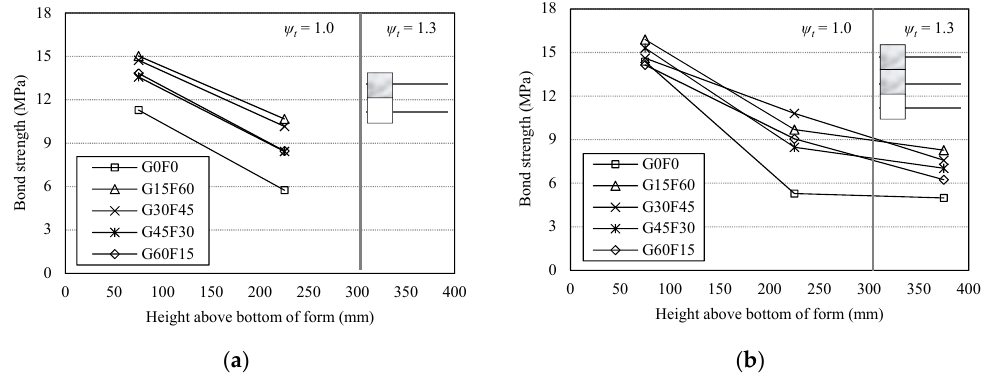
Figure 9. Comparison of bond strength levels in terms of location (height) of the rebar. ( a ) two-tiered specimens; ( b ) three-tiered specimen.